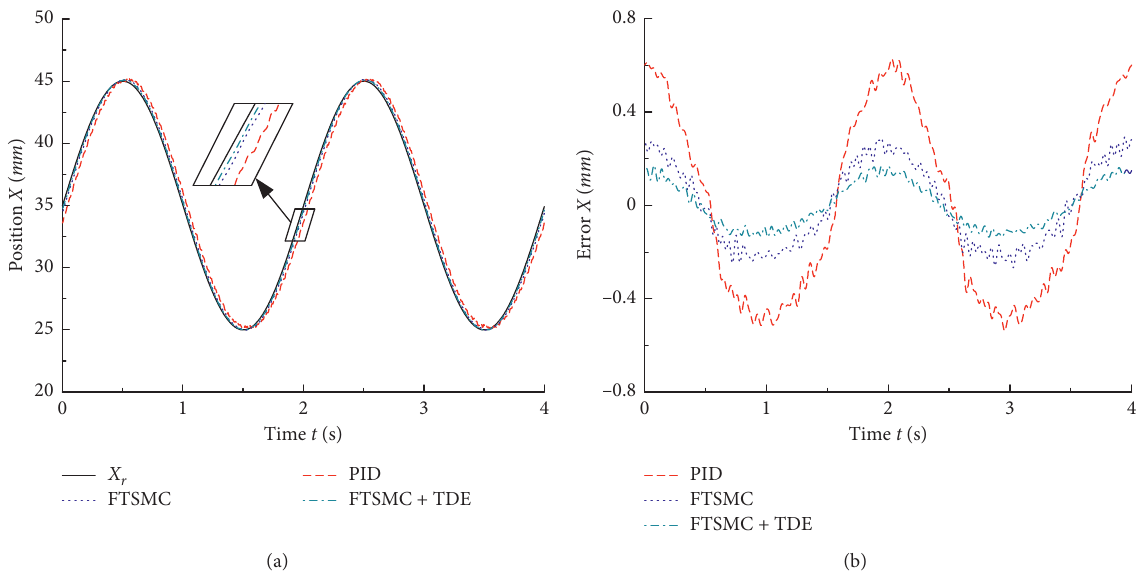
Figure 15: Position error under working condition ② in Table 5. (a) Position of 10mm amplitude and 1Hz frequency. (b) Position error of 10mm amplitude and 1Hz